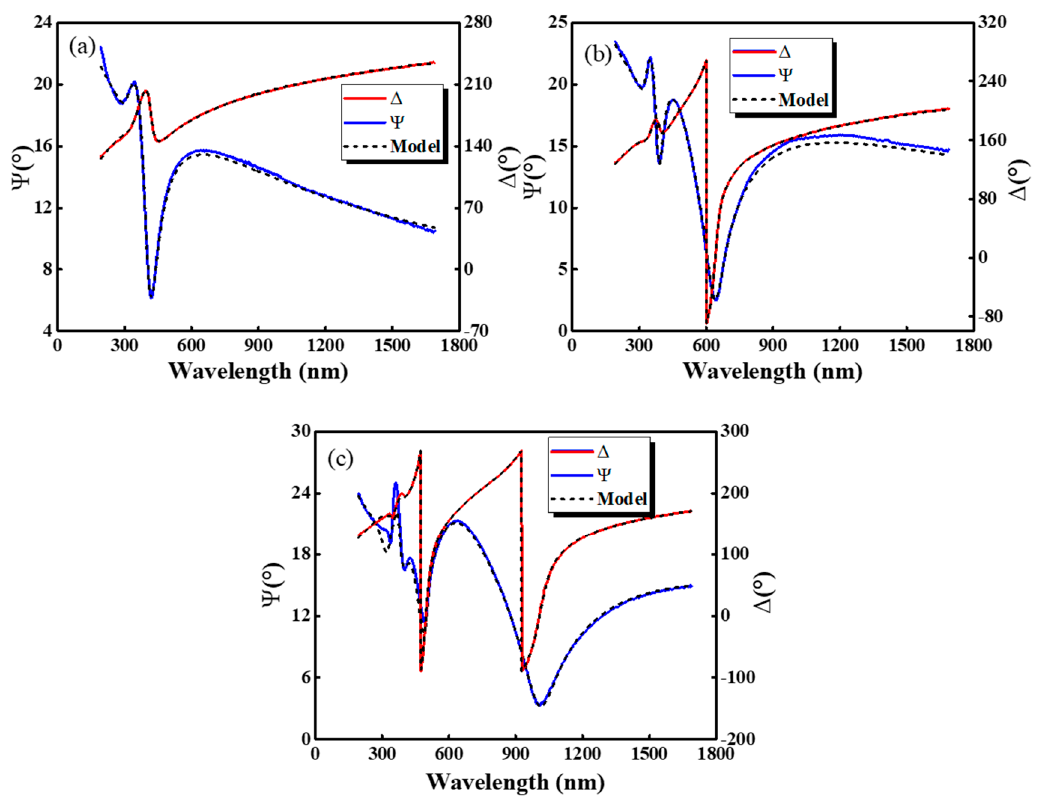
Figure 4. Spectra of the ellipometric parameters ( a ) Ψ and ( b ) ∆ at room temperature as functions of wavelength for the PZT thin films with different thickness at ( a ) 90 nm, ( b ) 164 nm and ( c ) 252 nm.